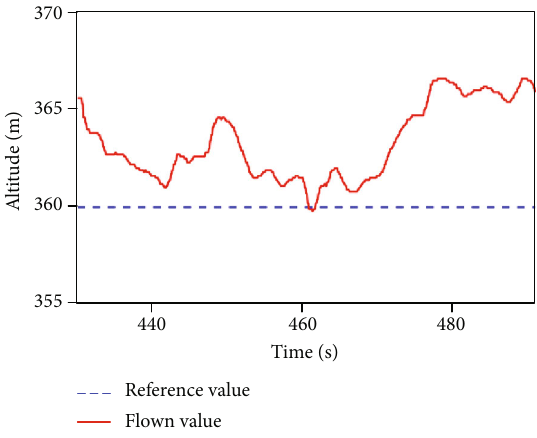
Figure 12: Altitude controller with the rudder as the only actuator. To control the altitude, the rudder itself is not enough; therefore, the airspeed has to be controlled, and if the airframe has to rise, the airspeed should not break